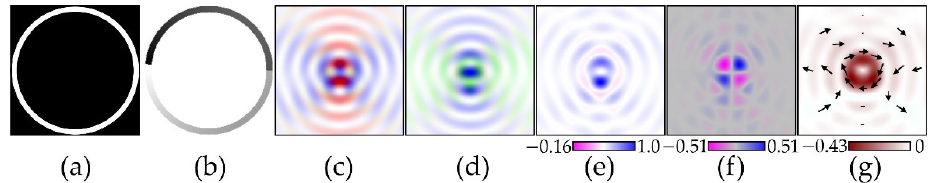
Figure 5. Simulation results for the input field with phase g 1 ( φ ) defined from Equation (37): ampli- tude ( a ) and phase ( b ) distribution of the input field; | E | 2 ( c ) and | H | 2 ( d ) distributions in the focal plane, as well as the distributions of Re[ P z ] ( e ), Im[ P z ] ( f ), and Re[ P γ ] ( g ).